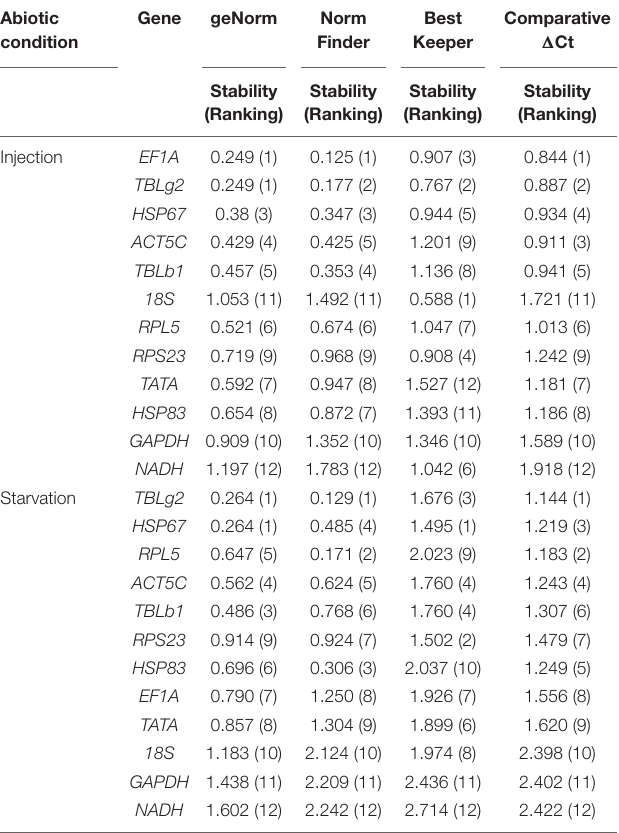
TABLE 3 | Stability of reference gene expression under abiotic conditions.